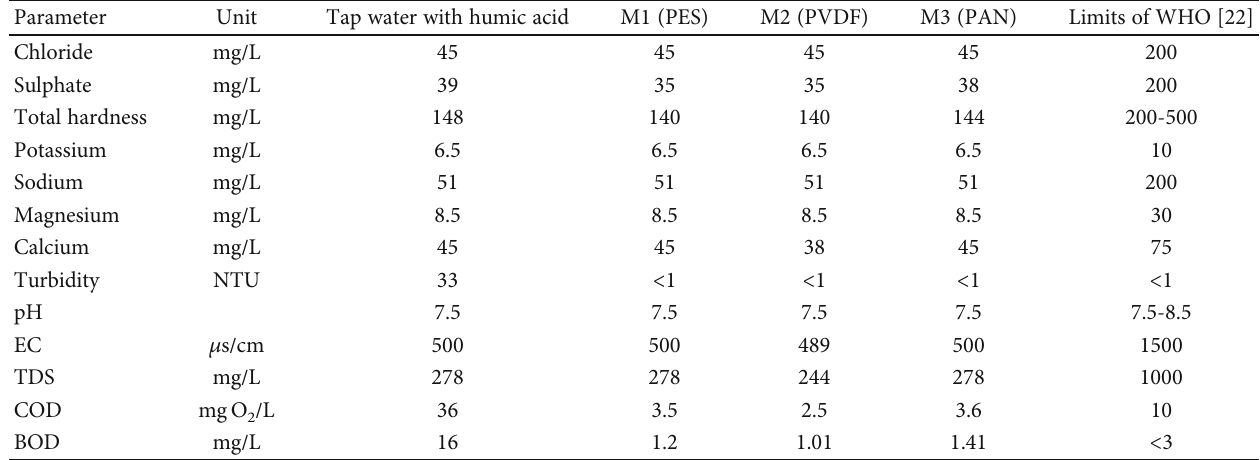
Table 3: Analysis of produced water after treatment by